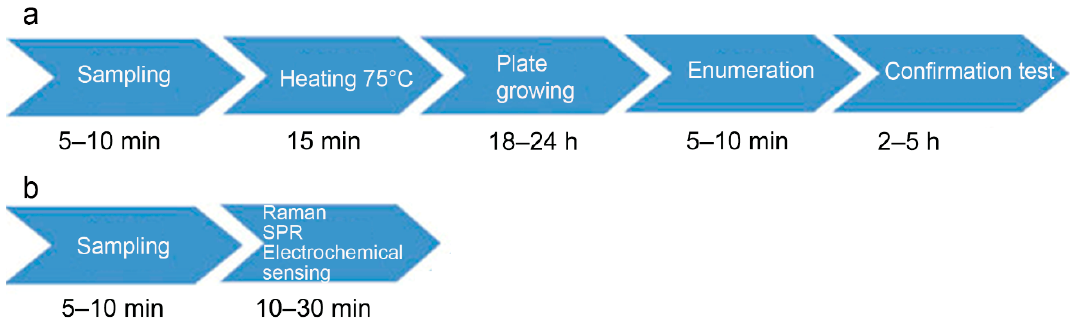
Figure 2 . Envisioned spore diagnostic workflow by a classical method ( a ) and biosensors ( b